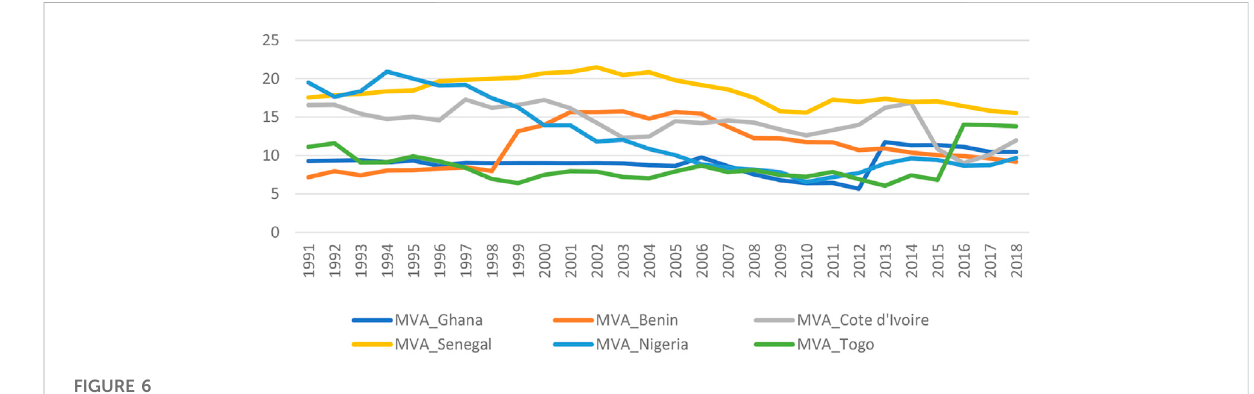
FIGURE 6 Manufacturing value-added levels of West African countries.